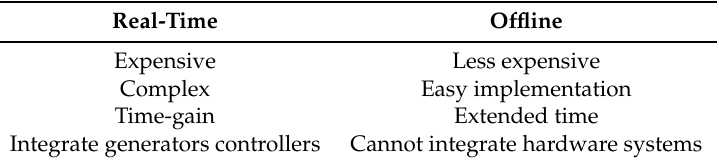
Table 3. Offline and Real-Time